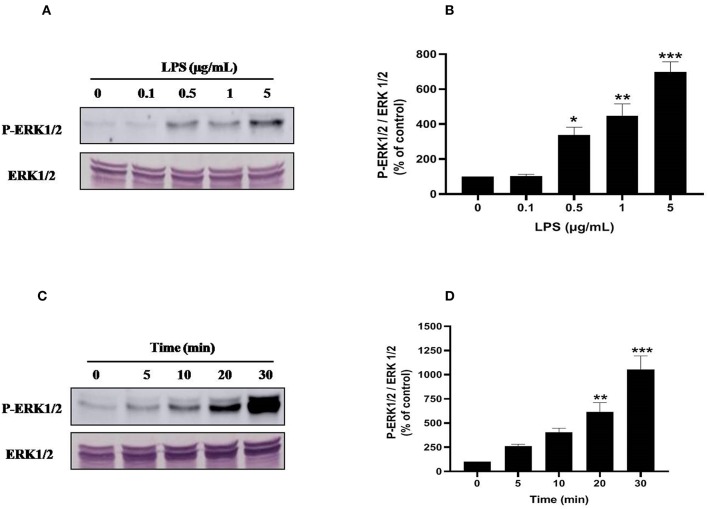
LPS induces ERK1/2 (p44/42 MAPK) activation in human neutrophils. (A) Neutrophils (10 × 106 cells/mL) were incubated with various concentration of LPS (0, 0.1, 0.5, 1, 5 μg/mL) for 20 min at 37°C. Cells were analyzed by SDS-PAGE and western blot using anti-phospho-ERK1/2 and anti-ERK1/2 antibodies. (B) Western blots from different experiments were scanned, total ERK1/2 were quantified by densitometry, and the intensity of phosphorylated ERK 1/2 was corrected for the protein amount of ERK1/2. (C) Neutrophils (10 × 106 cells/mL) were incubated with LPS (1 μg/mL) for indicated times (0, 5, 10, 20, 30 min). Cells were analyzed by SDS-PAGE and immunoblotting with anti-phospho-ERK1/2 and anti-ERK1/2 antibodies. (D) Western blots from different experiments for the kinetic effect were scanned and phosphorylated, total ERK1/2 were quantified by densitometry, and the intensity of phosphorylated ERK1/2 was corrected for the protein amount of ERK1/2. Data are mean ± SEM of three or more separate experiments. *p < 0.05, **p < 0.01 and ***p < 0.001 as compared to control (100%).